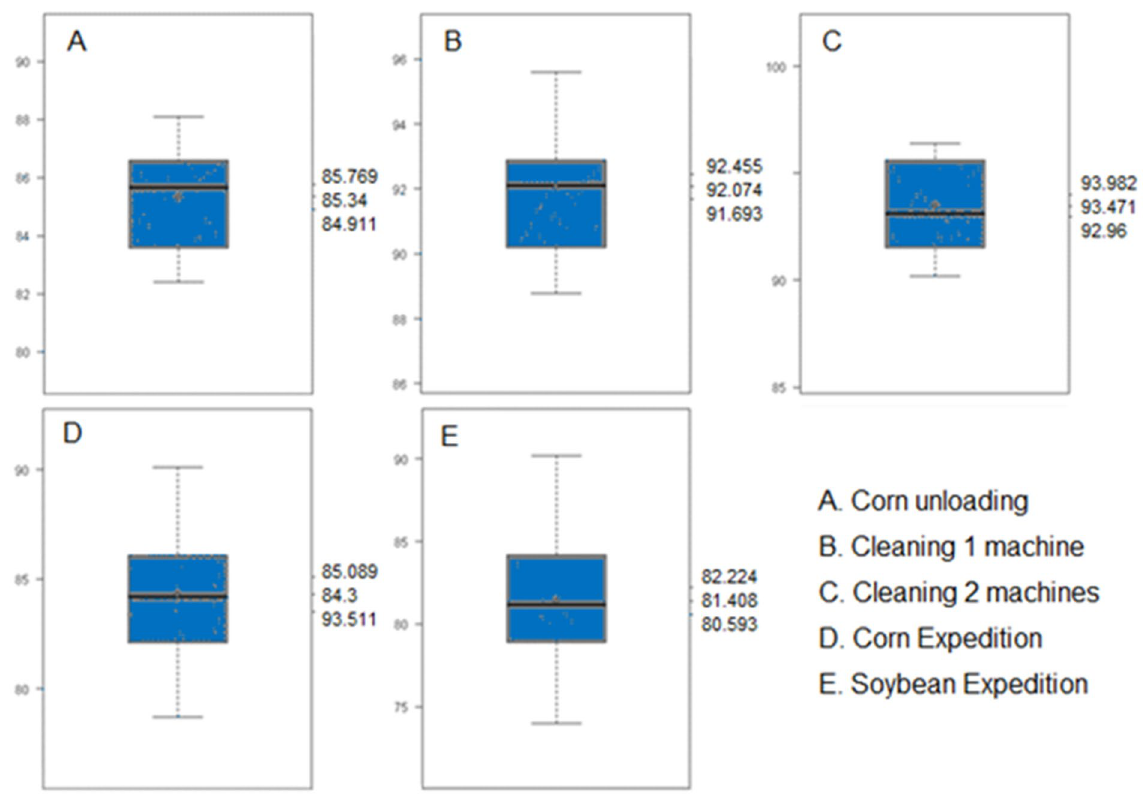
Figure 5. Noise level measurement on Upper Confidence Limit (UCL), average and Lower Confidence Limit (LCL) at corn unloading ( A ), corn cleaning with one machine ( B ) operation, corn cleaning with two machines ( C ) operation, corn expedition ( D ) and soybean expedition ( E